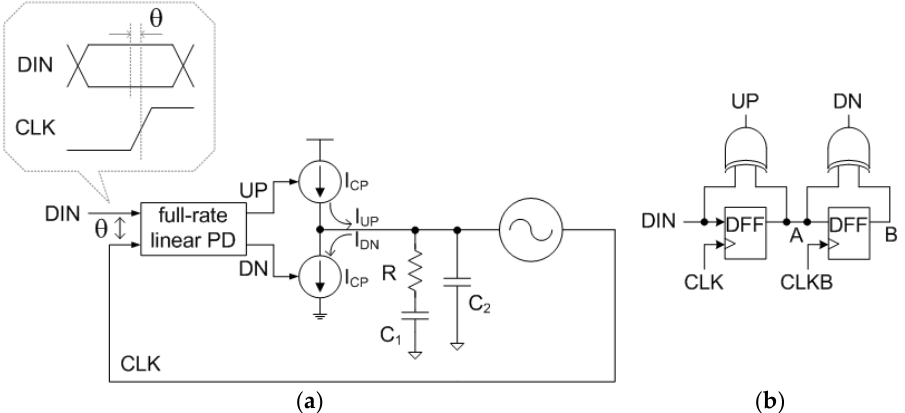
Figure 1. ( a ) The referenceless single-loop clock and data recovery (CDR) architecture including ( b ) the full-rate Hogge linear phase detector (PD).